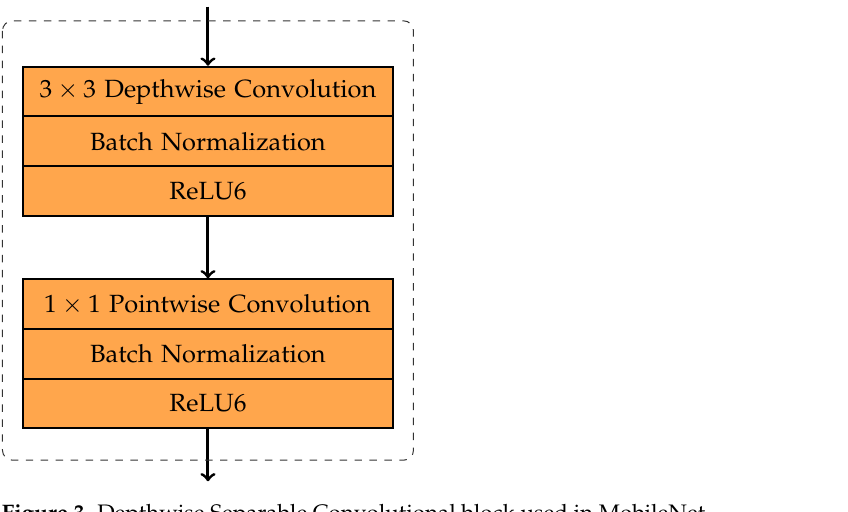
Figure 3. Depthwise Separable Convolutional block used in